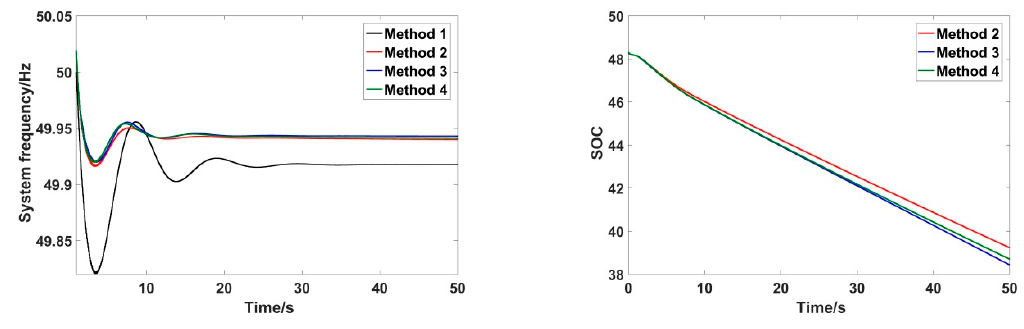
Figure 12. Results of 17 MW step load disturbance.